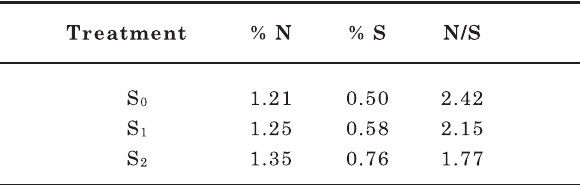
Table 5. Chemical analyses of kohlrabi leaves (% in dry matter)